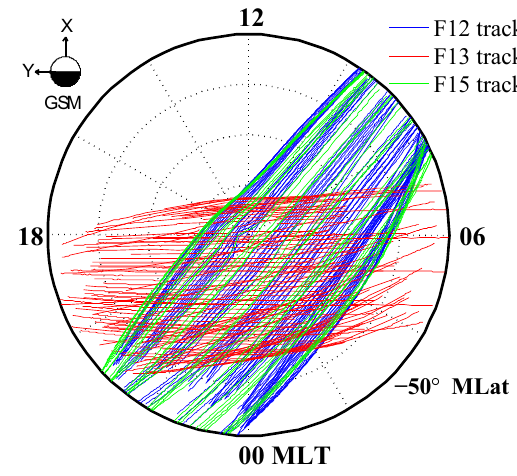
Figure 1. Ground tracks of DMSP-F12 (blue lines), F13 (red lines) and F15 (green lines) in the high latitude over the southern